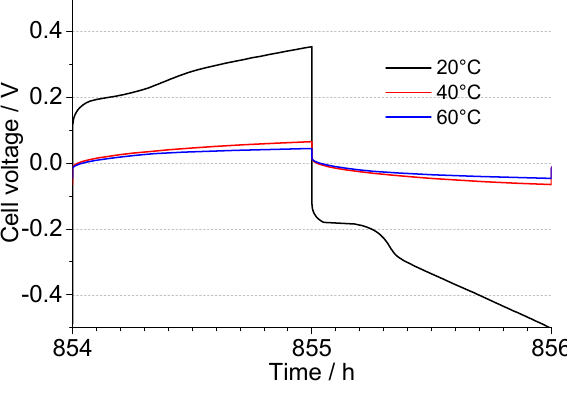
Figure 6. Voltage profile of Li/0.9 Pyr galvanostatic cycling at temperatures as indicated on the